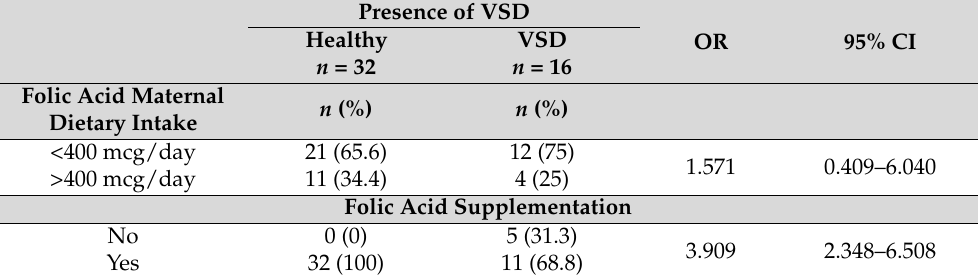
Table 2. Associations between folate intake and the risk of